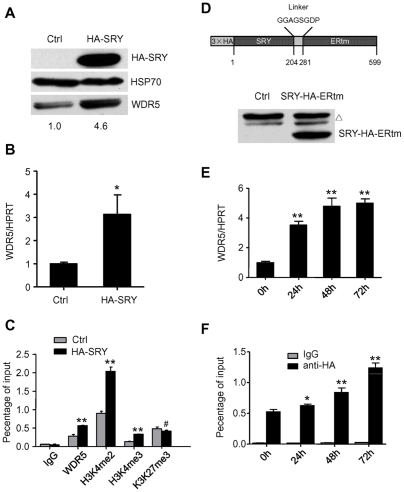
SRY activates WDR5 expression.(A) Western blot analysis of HA tagged SRY, Hsp70, and WDR5 from LNCaP cells containing either control vector (Ctrl) or HA-tagged SRY. Relative quantitation of WDR5 protein with ImageJ software (NIH, USA) is shown on the bottom. (B) Quantitative real-time analysis of WDR5 levels as in (A). Graphs show mean ± SD, n = 3. (C) ChIP analysis on WDR5 promoter with indicated antibodies as in (A). Graphs show mean ± SD, n = 3. (D) Schematic representation of HA-SRY-ERtm construct. Numbers show the respective amino acid positions of the individual constituents (upper panel). Western blot analysis of SRY-HA-ERtm expression with anti-HA antibody. A triangle indicates non-specific bands (lower panel). (E) Quantitative real time analysis of WDR5 levels from cells with SRY-3HA-ERtm after induction by 4-OHT at indicated time points. Graphs show mean ± SD, n = 3. (F) ChIP analysis on WDR5 promoter with either IgG or anti-HA antibody as in (E). Graphs show mean ± SD, n = 3. *P<0.05, **P<0.01, #P>0.05 compared to control; Student's t-test.